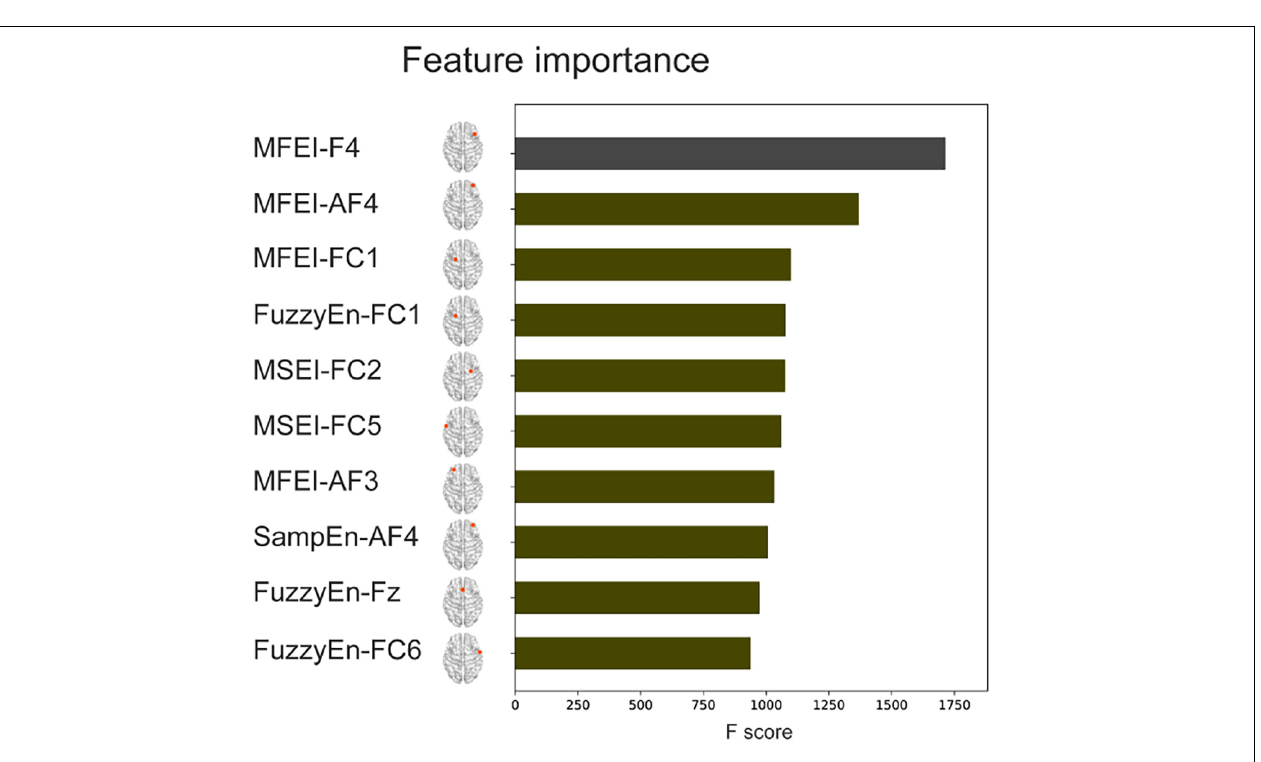
FIGURE 7 | Feature importance of Combined-XGBoost (top 10